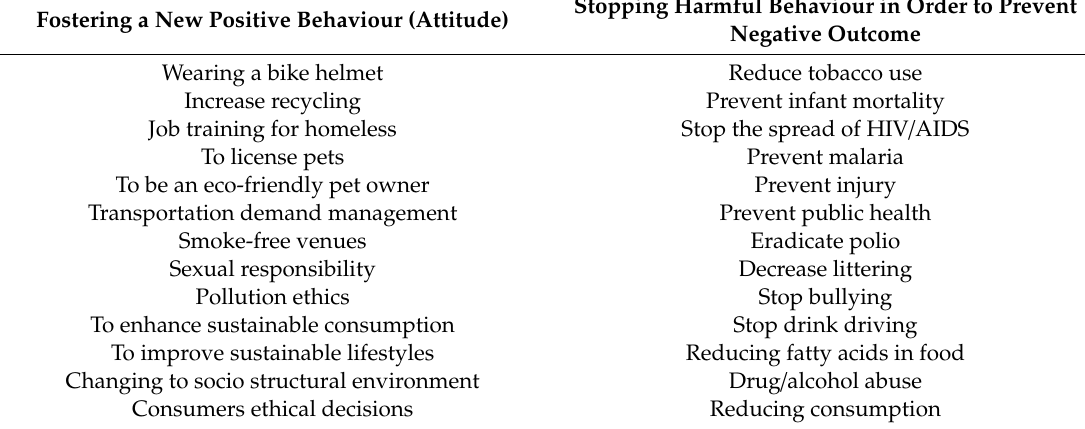
Table 2. Goals of social marketing (samples).